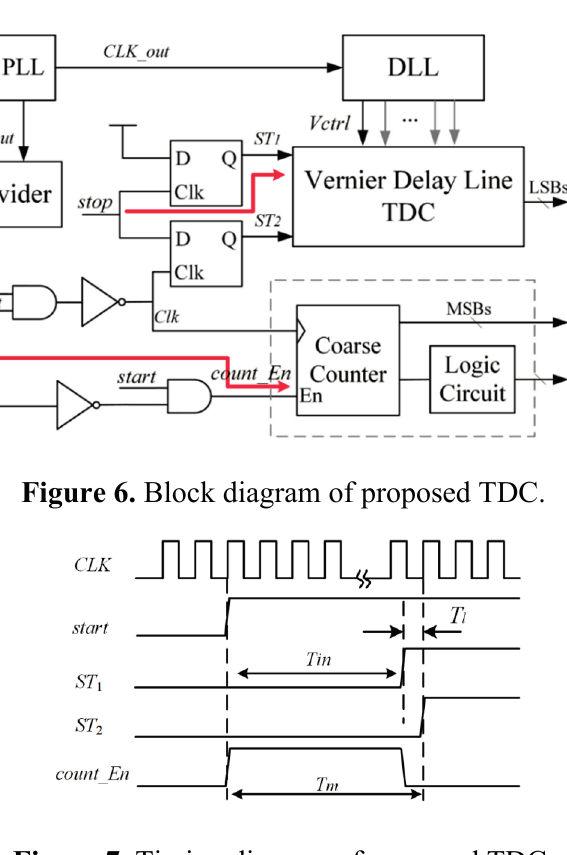
Figure 7. Timing diagram of proposed